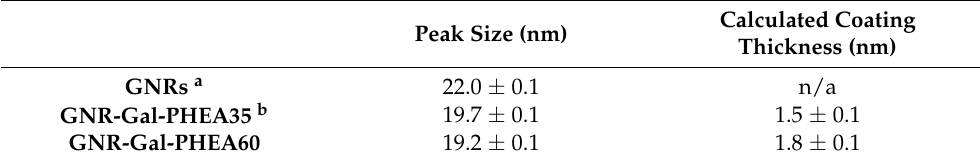
Table 1. Characteristics of the GNRs, GNR-Gal-PHEA35 and